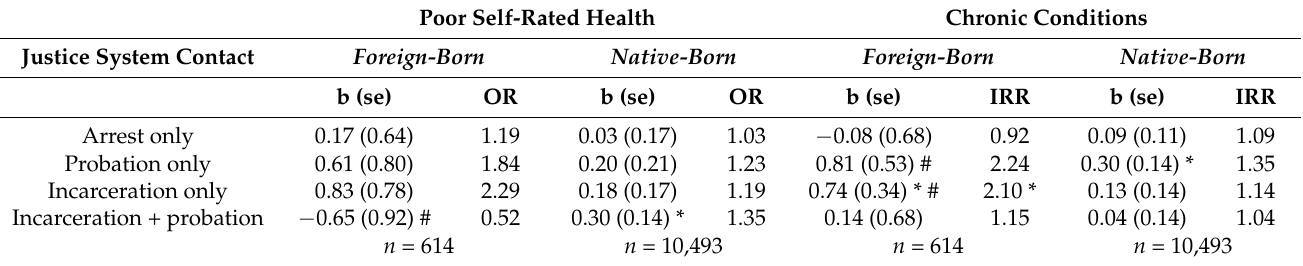
Table 2. Ordinal and Poisson regression models examining justice system contact on health by nativity among U.S. adults in Wave IV of the National Longitudinal Study of Adolescent Health. Poor Self-Rated Health Chronic